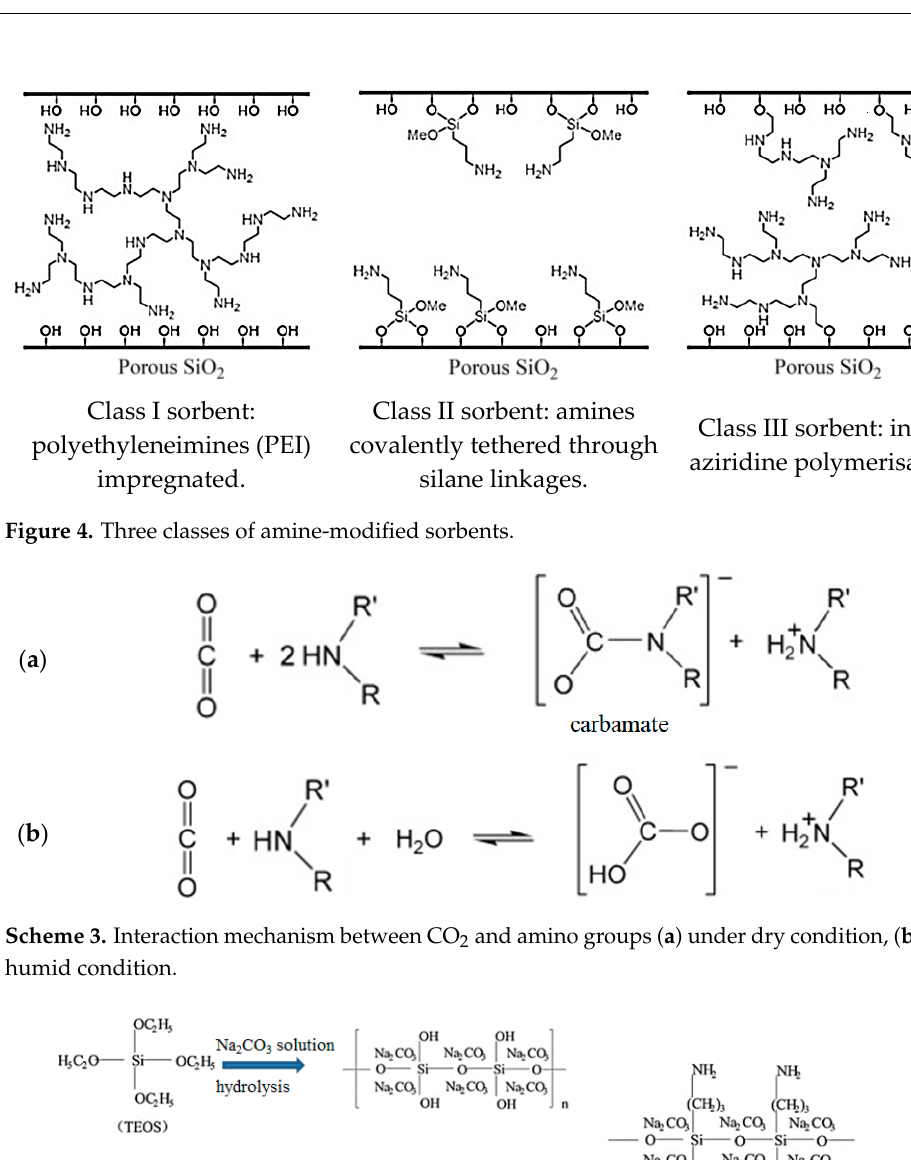
Scheme 3. Interaction mechanism between CO 2 and amino groups ( a ) under dry condition, ( b )